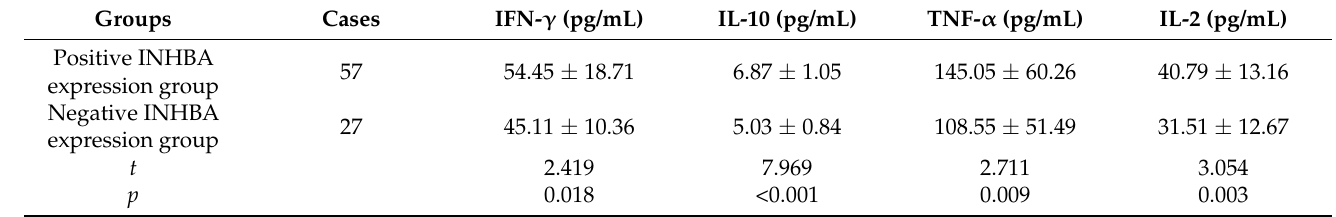
Table 3. The relationship between INHBA expression and the anti-tumor immune response in CC ( x ± s